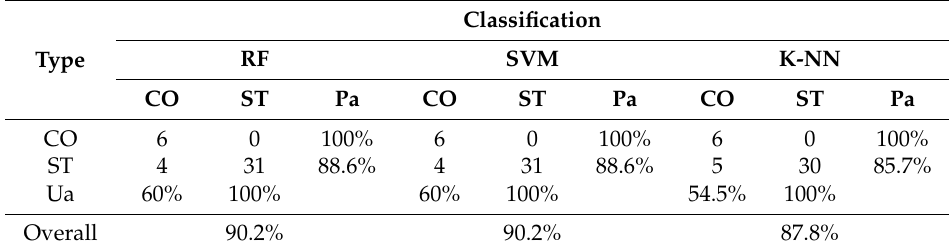
Table 6. Classification results of Image 2 using different methods (CO = totally collapsed building, ST = standing building; Pa = producer’s accuracy, Ua = user’s accuracy).